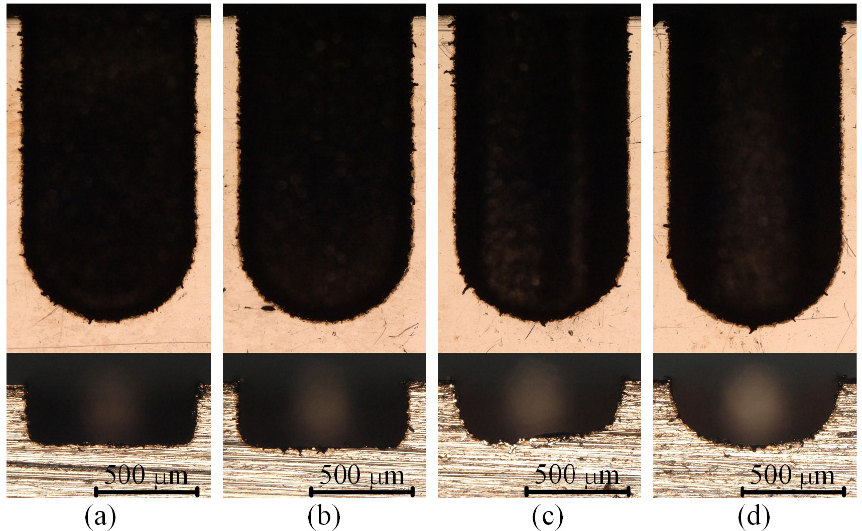
Figure 20. Optical images of the top view and back view of the four grooves in Exp. 2: ( a ) hollow electrode-rotating mode; ( b ) cylindrical electrode-rotating mode; ( c ) hollow electrode-nonrotating mode; ( d ) cylindrical electrode-nonrotating mode.